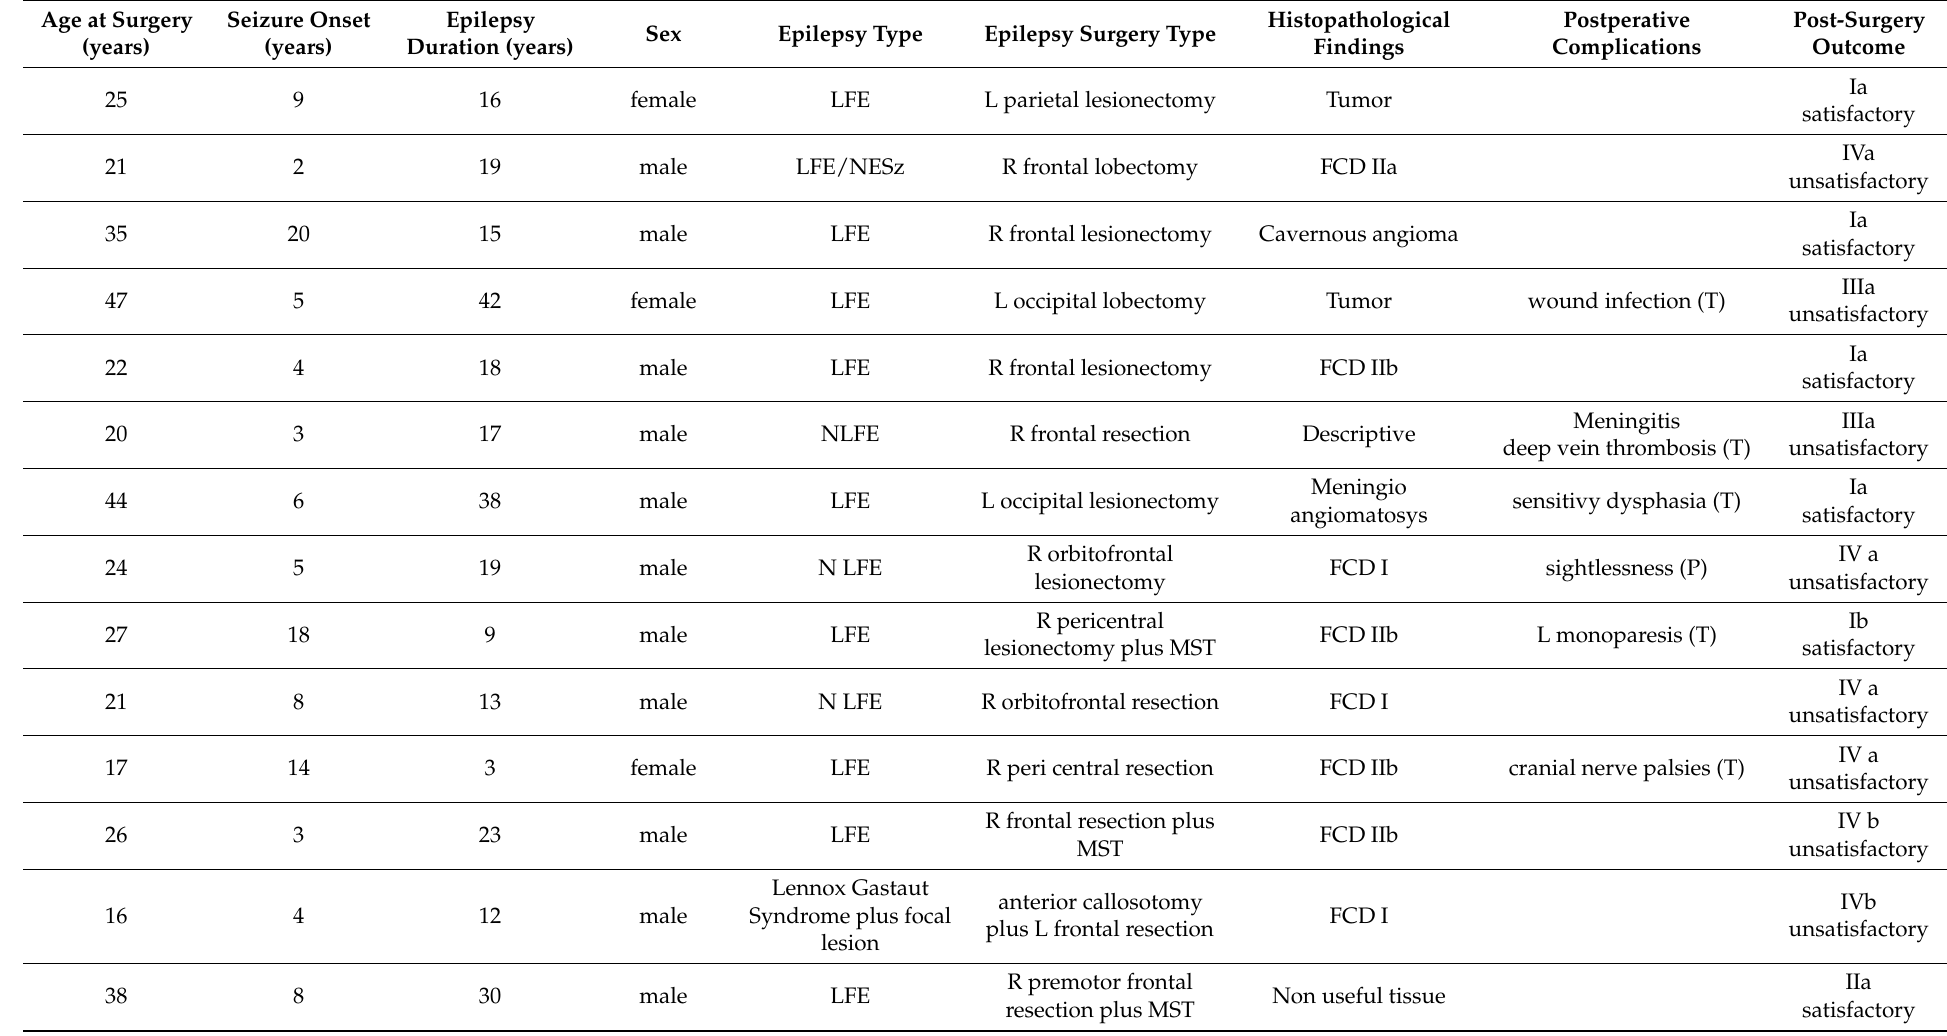
Table 1. Demographic, clinical and surgery